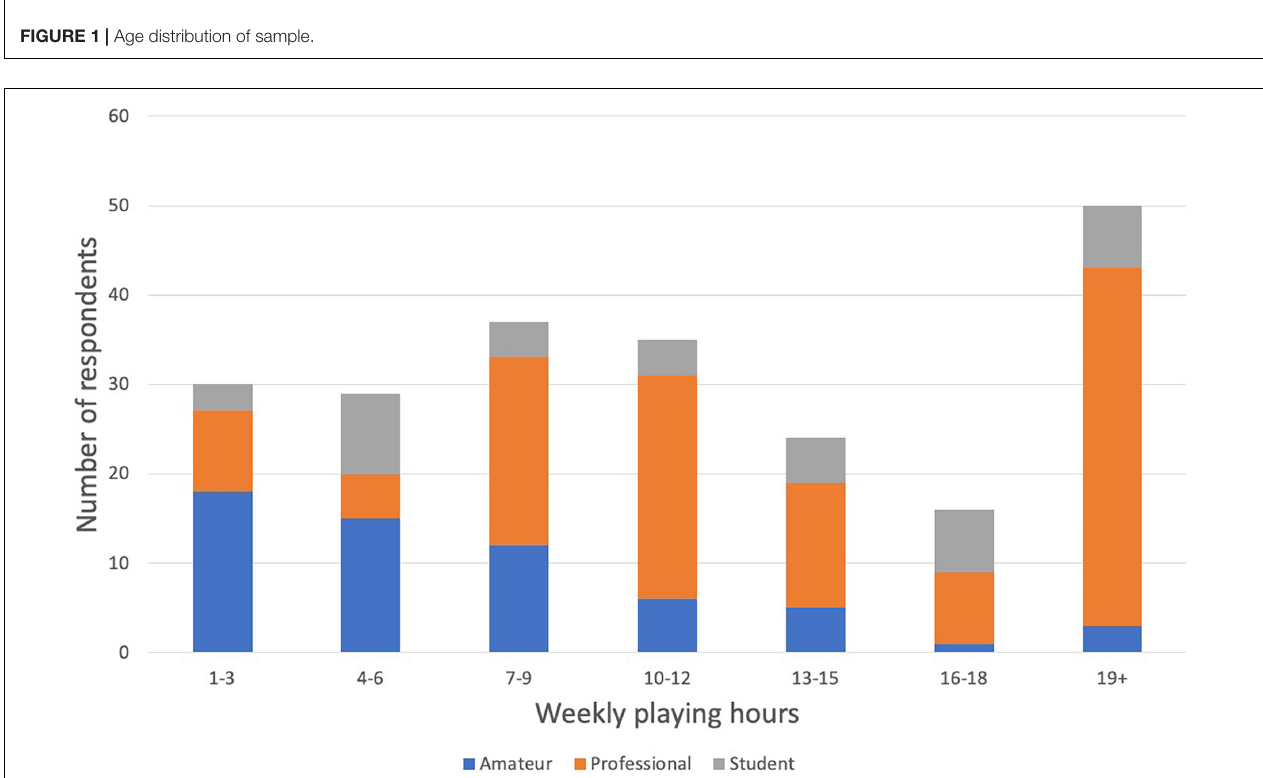
FIGURE 2 | Weekly playing hours responses by career